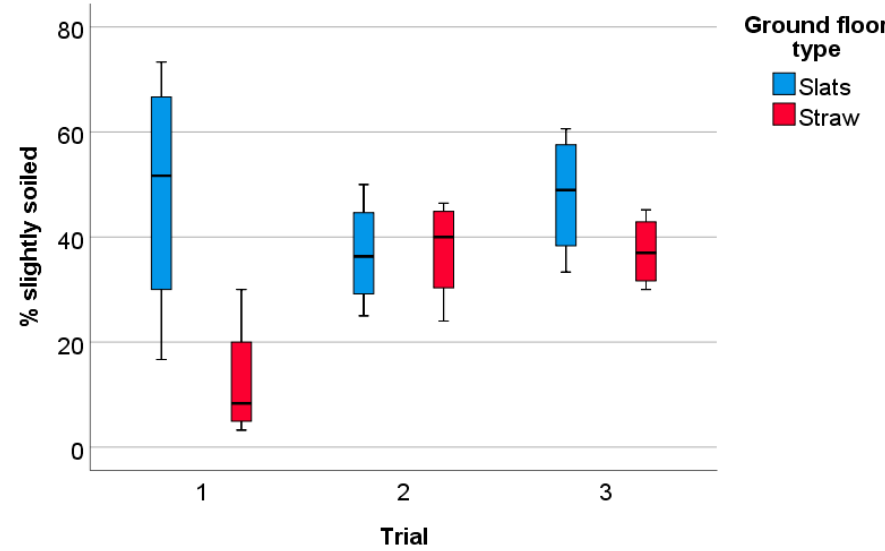
Figure 2. Percentages of slightly soiled animals per pen in Slat pens (ground floor consisting of slatted plastic panels, n = 4 per trial) and Straw pens (pens with the ground floor consisting of concrete littered with straw, n = 4 per trial).